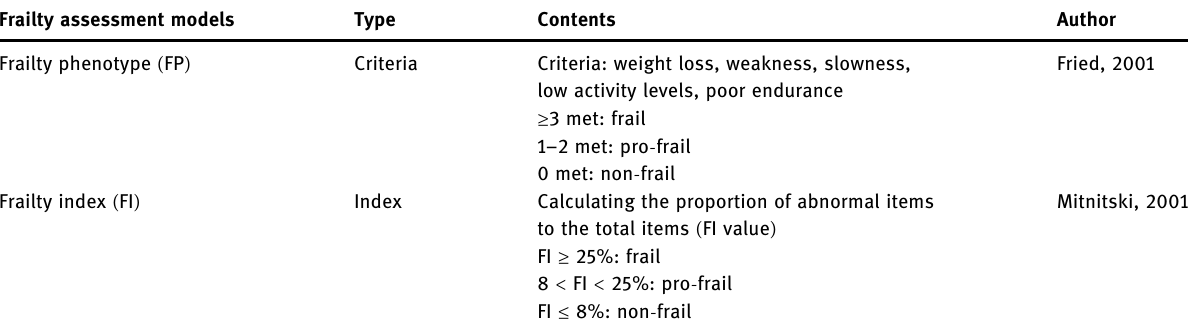
Frailty assessment